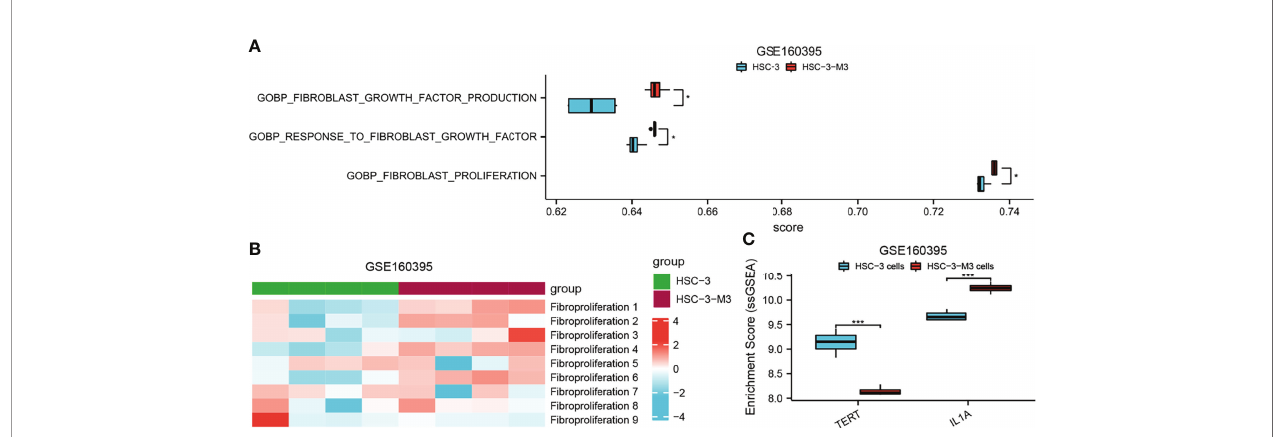
FIGURE 9 | The role of AFOC-DEGs and fi broproliferation-related biological processes in the metastasis of HSC. (A) Heatmap shows the relationship between fi broproliferation-related biological processes and HSC metastasis. (B) Dot plot shows differences in fi broproliferation-related biological processes between HSCs and metastasis HSCs; a rank-sum test was used to analyze the data (n = 328, *p < 0.05). (C) Dot plot shows differences in the expression of TERT and LI1A between HSCs and metastasis HSCs; a rank-sum test was used to analyze the data (n = 328, ***p <